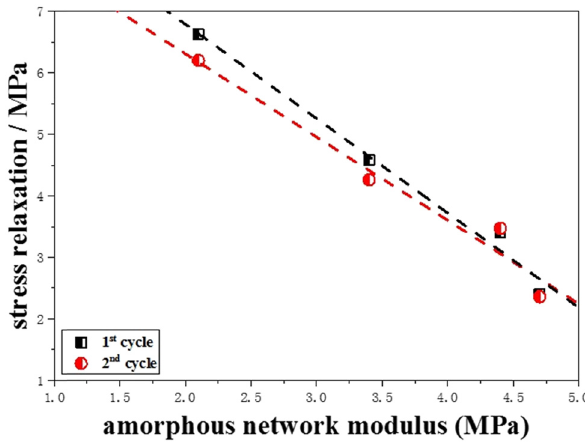
Figure 7: The stress relaxation during two - cycle stretching of fi